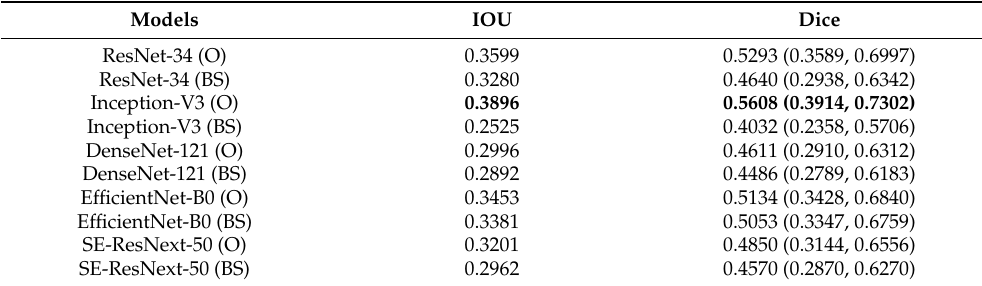
Table 2. TB-consistent lesion segmentation performance using original (O) and bone-suppressed (BS) CXRs. Values in parentheses denote the 95% CIs for the dice score. Bold numerical values denote superior